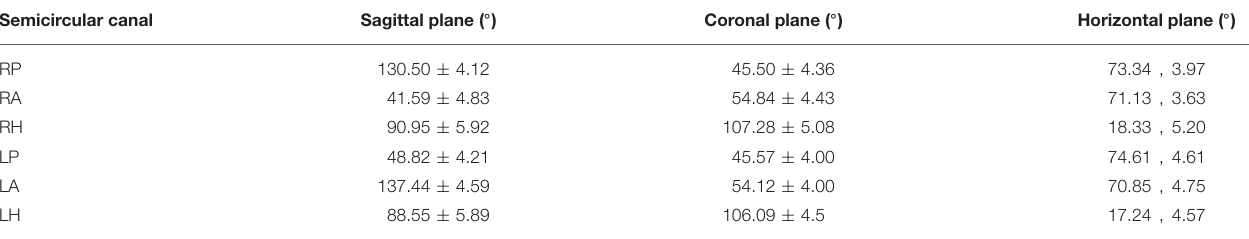
P, posterior semicircular canal; A, superior semicircular canal; H, lateral semicircular canal; R, right; L,